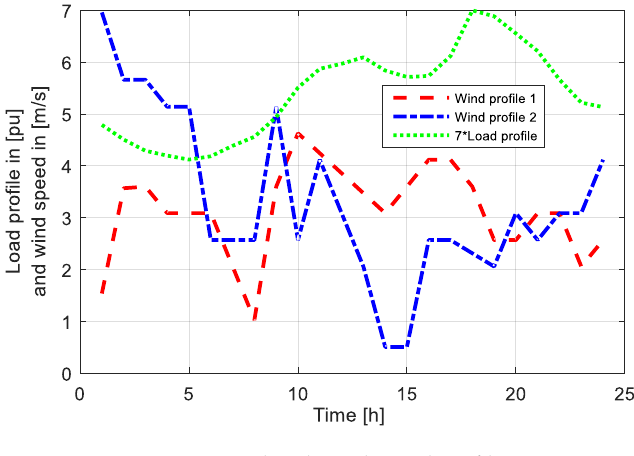
Figure 8. Load and wind speed profiles. Table 6. Power losses (MW) without and with SVC in the IEEE 9 test bus system—CASE